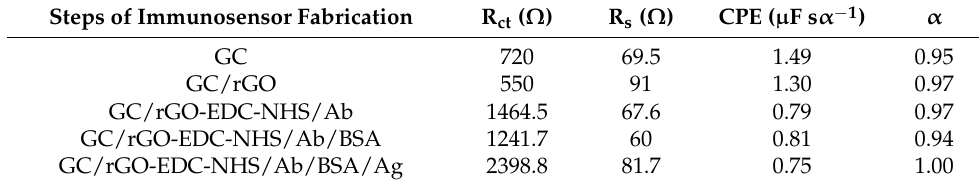
Table 1. Resume of fitted parameters of EIS experiments.